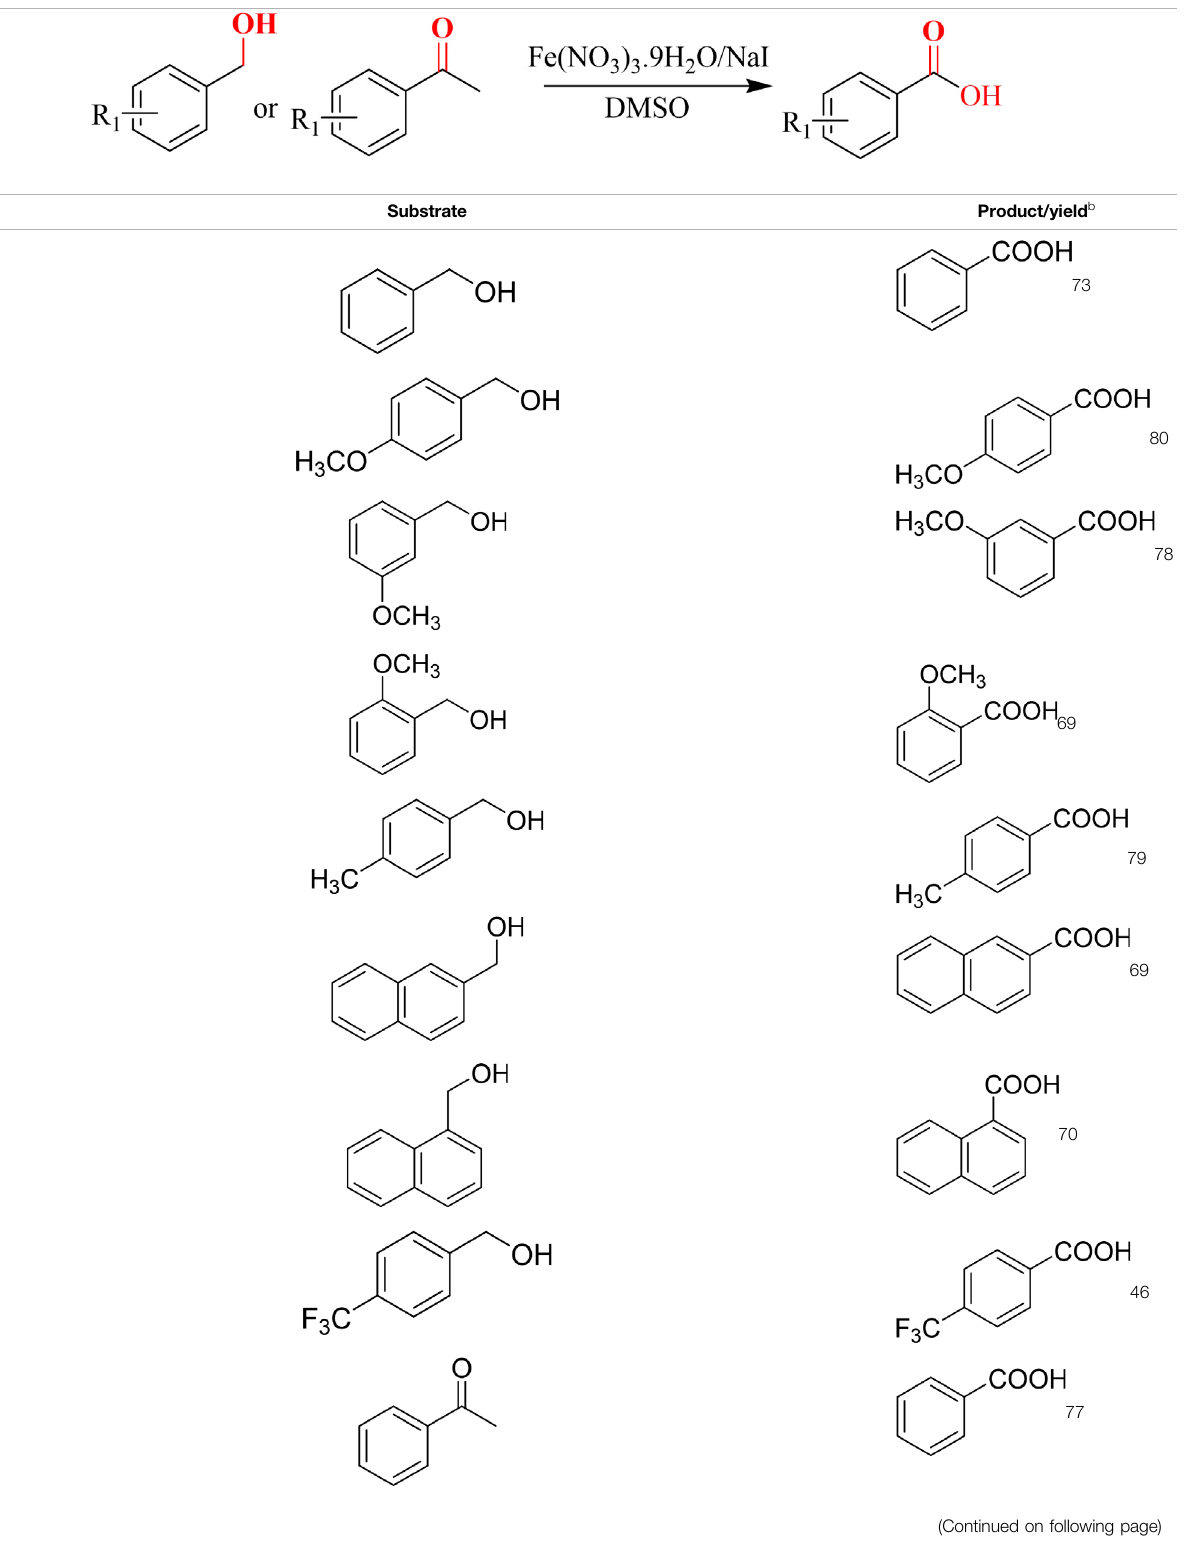
TABLE 3 | Catalytic aerobic oxidation of primary alcohols and ketones a